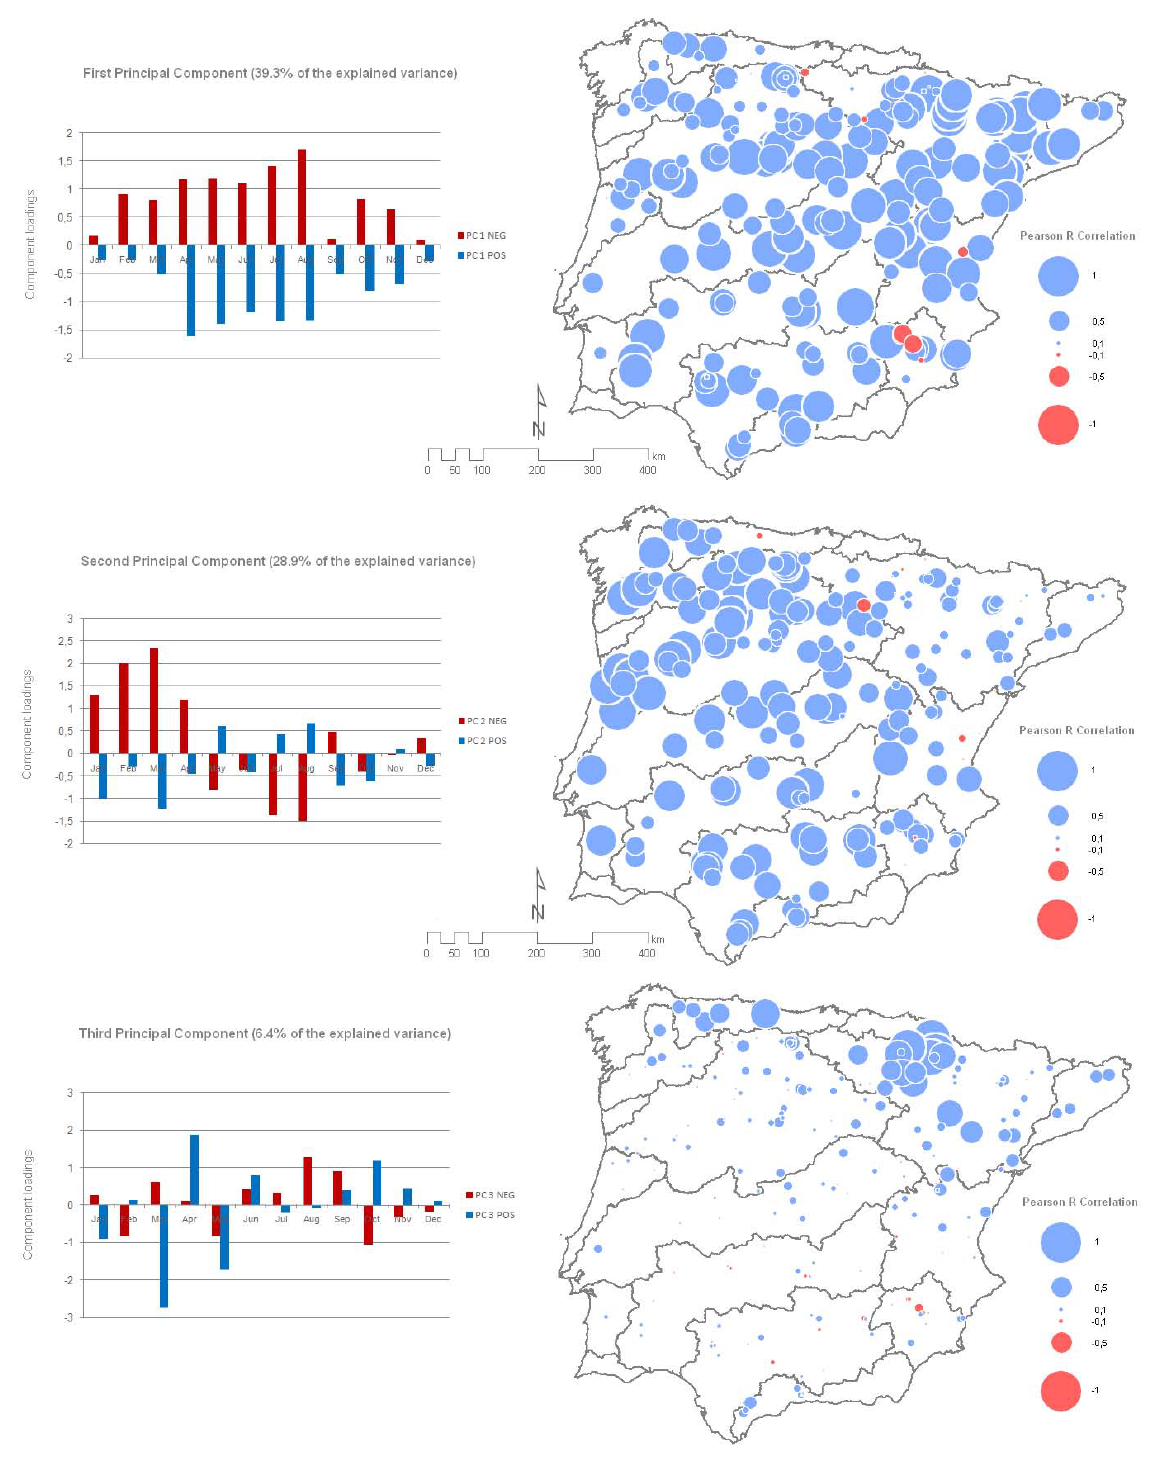
Fig. 6. The scores of the three first Principal Components extracted from the anomalies series during positive (blue bars) and negative (red bars) NAO phases (left column). Spatial distribution of the correlation coefficients between the scores of the Principal Components and the original anomalies registered at every gauging station (right